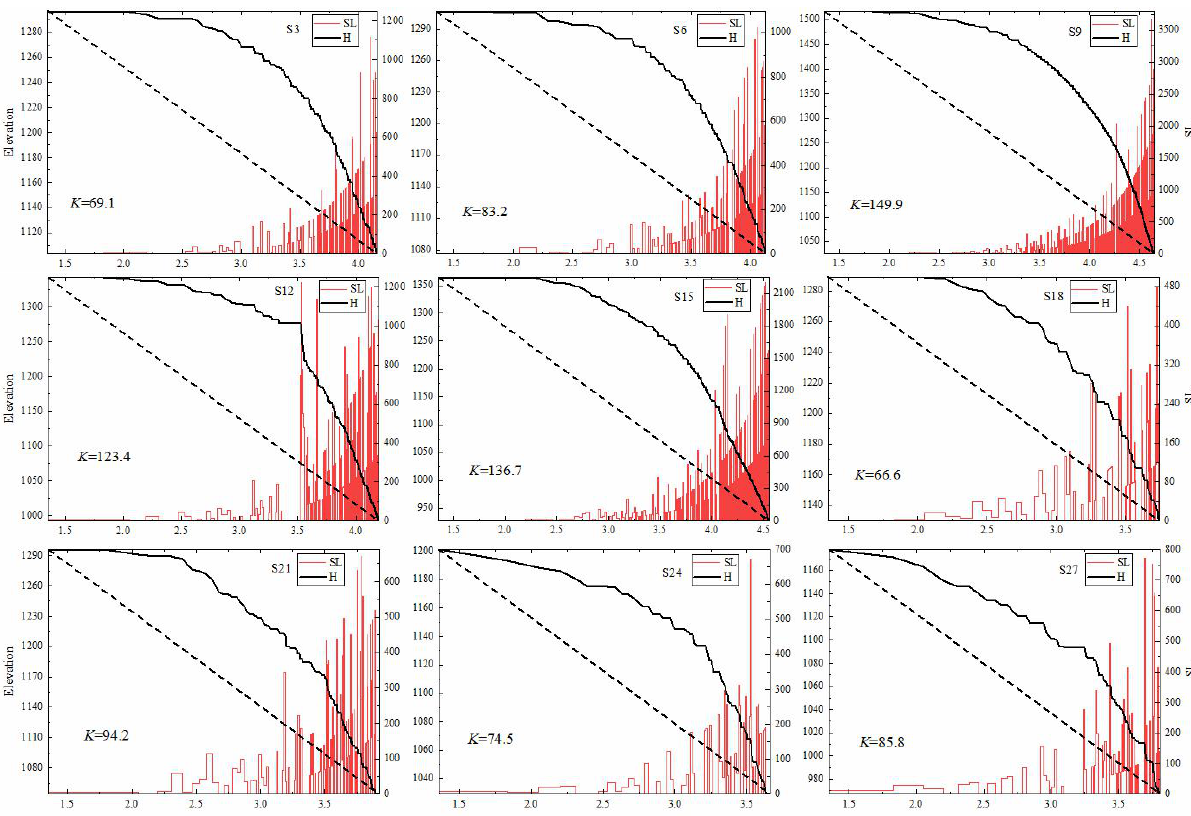
Figure 5. SL index and Hack profile of 9 major tributaries in the the Daxi river basin.